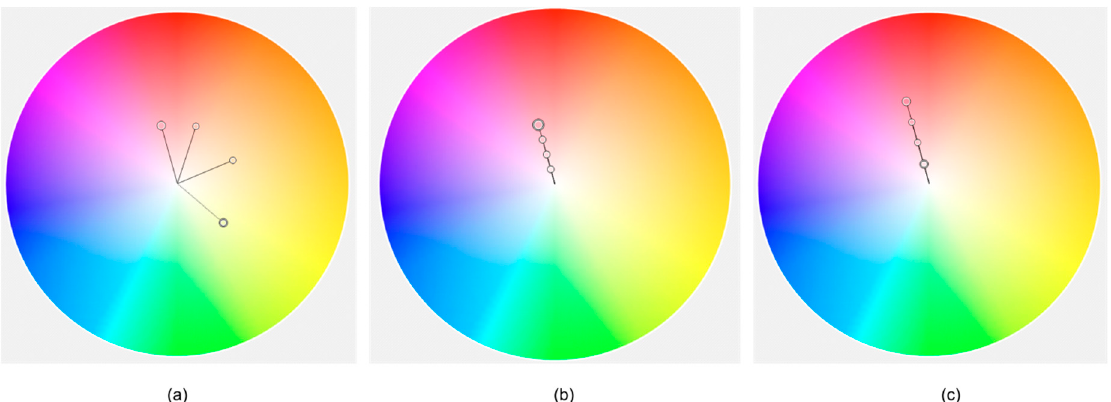
Figure 9. OpenStreetMap road network colors suggestions plotted in the color wheel: ( a ) for analogous color scheme; ( b ) and ( c ) alternatives for monochromatic color schemes.